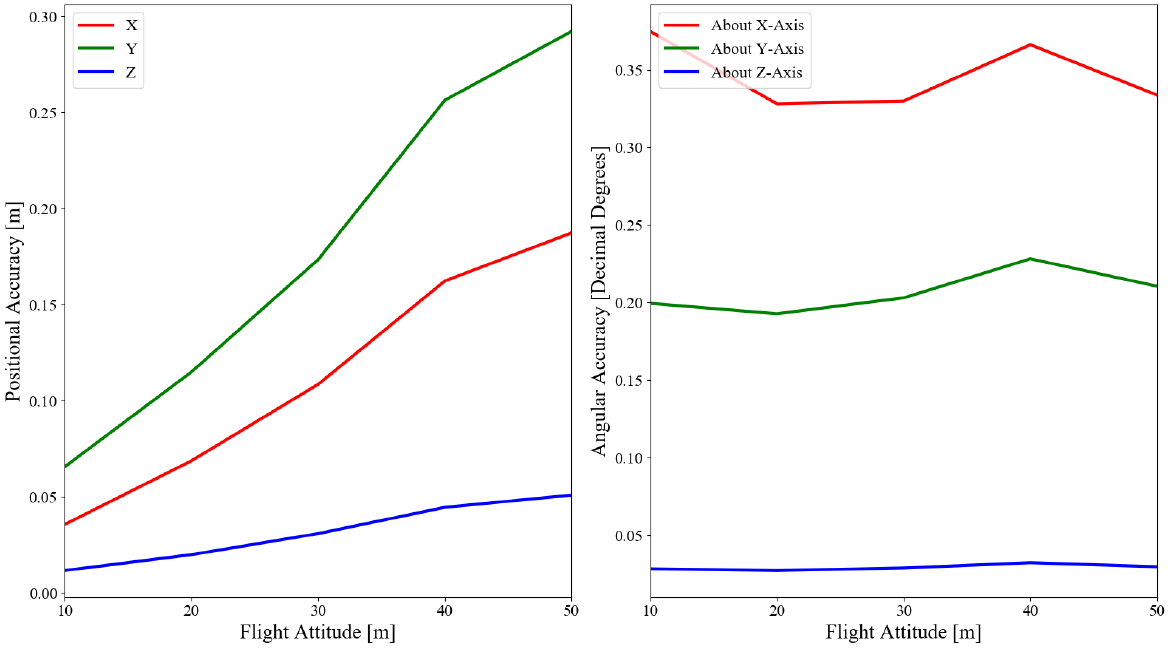
Figure 5: Altitude implications on pose accuracy for stereo vision